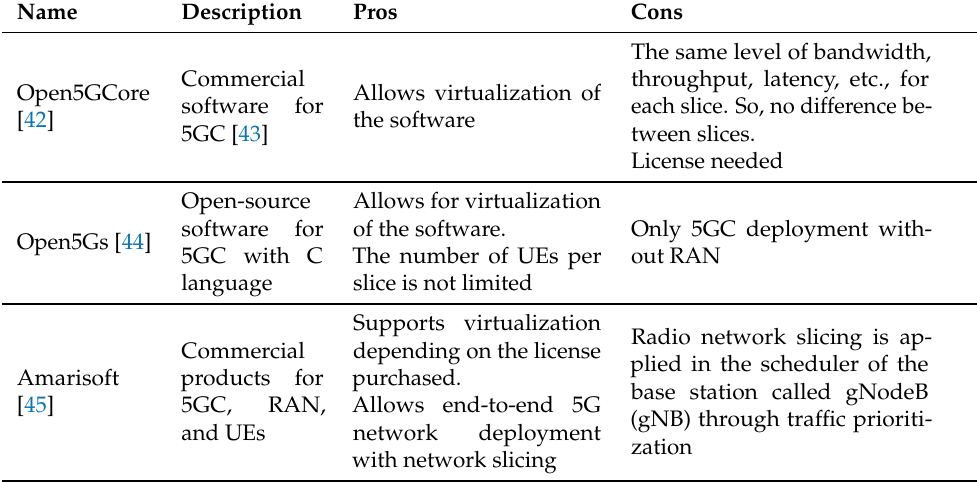
Table 4. Analysis of network slicing